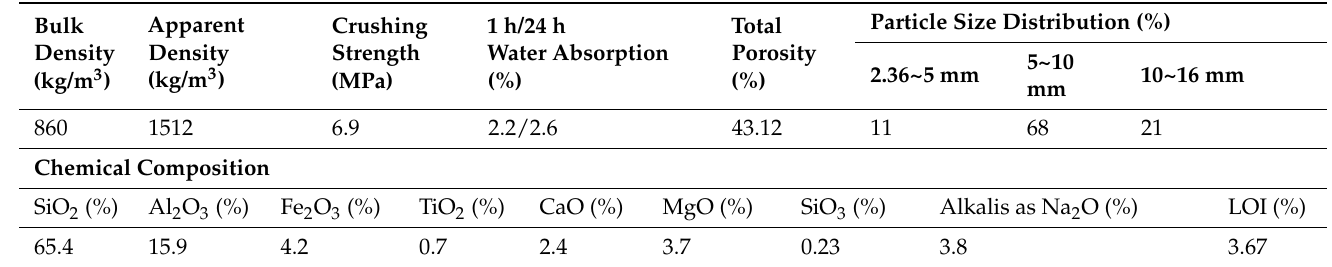
Table 1. Properties of